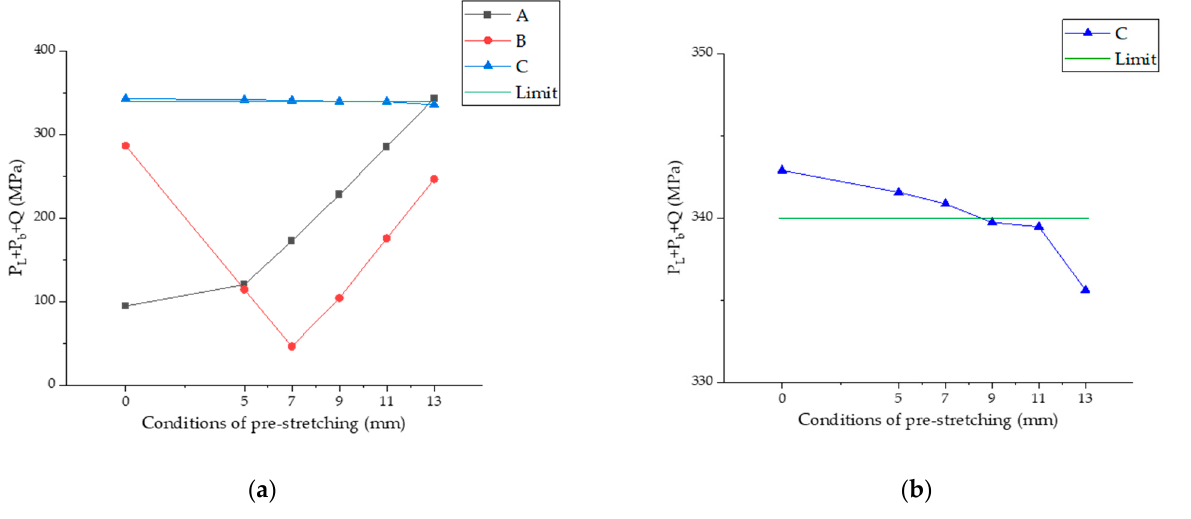
Figure 11. P L + P b + Q assessment under load case 1 with varying pretensions. ( a ) At positions A, B and C. ( b ) Magnification at position C. and C. ( b ) Magnification at position C.